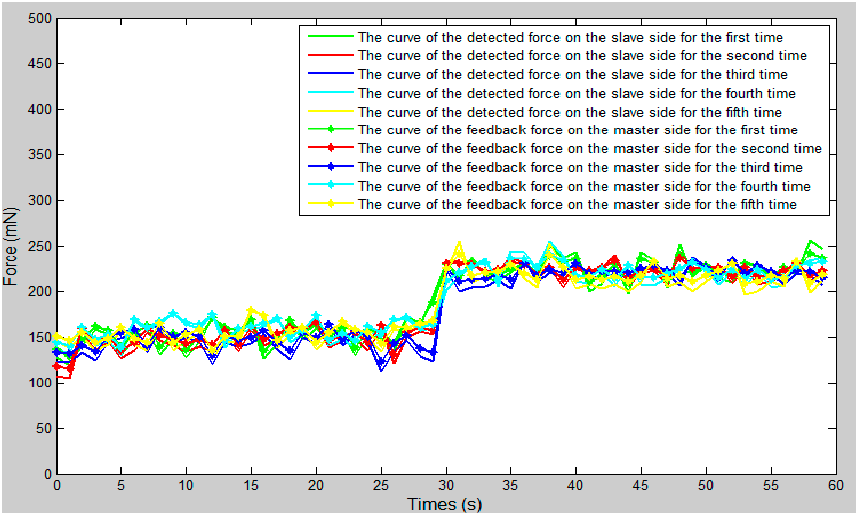
Figure 13. The comparison curve between the slave detected force with the master feedback force.